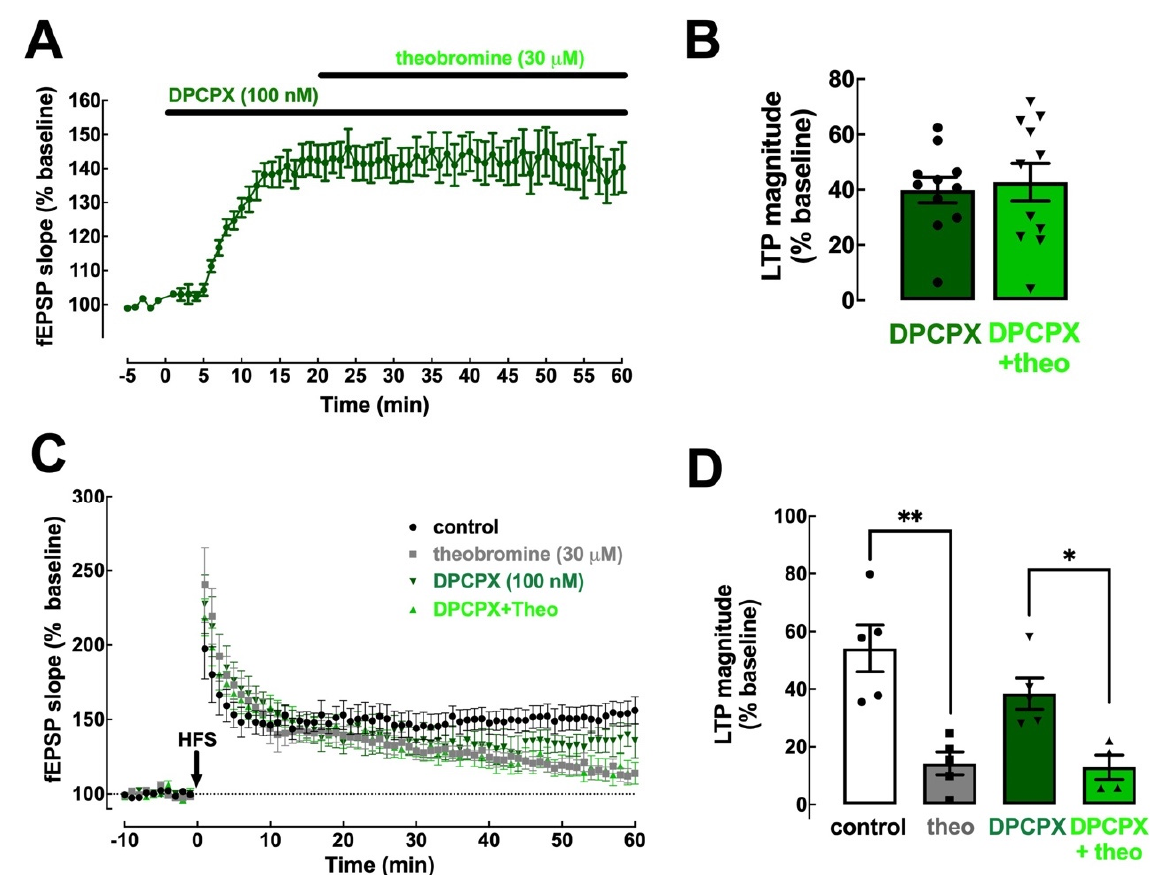
Figure 3. Blockade of A 1 R eliminates the impact of theobromine on basal synaptic transmission but not on synaptic plasticity. The selective A 1 R antagonist DPCPX (100 nM) enhanced basal synaptic transmission and occluded the effect of theobromine (theo, 30 µ M) on synaptic transmission ( A , B ). In contrast, DPCPX did not modify the magnitude of long-term potentiation (LTP), induced with a high-frequency stimulation train (HFS: one train of 100 pulses of 1 Hz for 1 s), recorded in Schaffer fiber-CA1 pyramid synapses of mouse hippocampal slices and failed to modify the effects of theobromine on LTP magnitude ( C , D ). Data are mean ± S.E.M. of 11 ( A , B ) and 5–6 ( C , D ) experiments. The asterisks denote significant differences: * p < 0.05 and ** p < 0.01, two-way ANOVA with Tukey’s post hoc test.